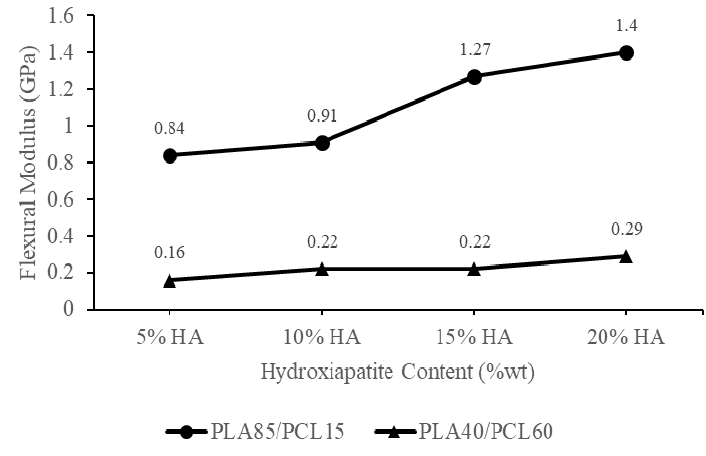
Figure 6. Flexural modulus of the PLA/PCL/HA biocomposites.